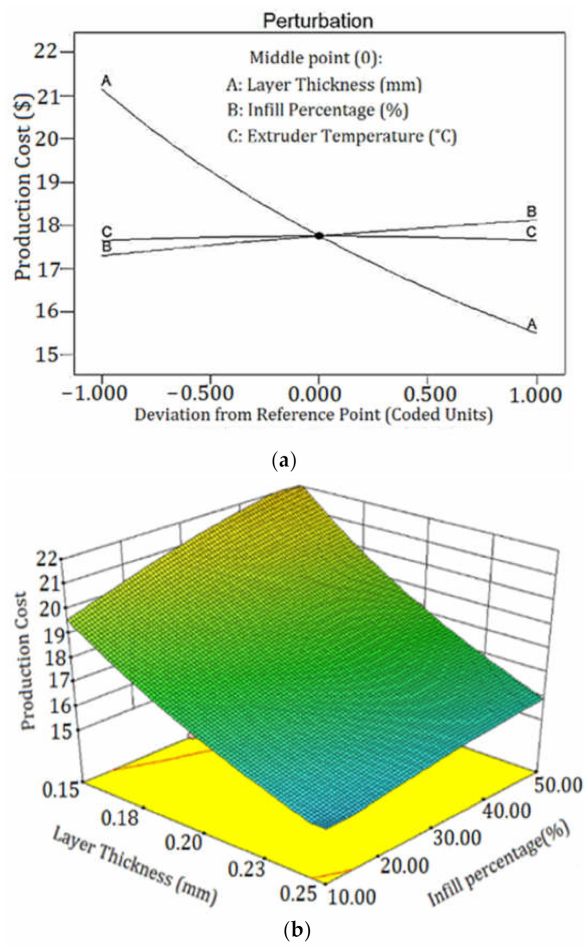
Figure 11. ( a ) Perturbation plot of production cost and ( b ) 3D-SP of production cost in phases of LT and